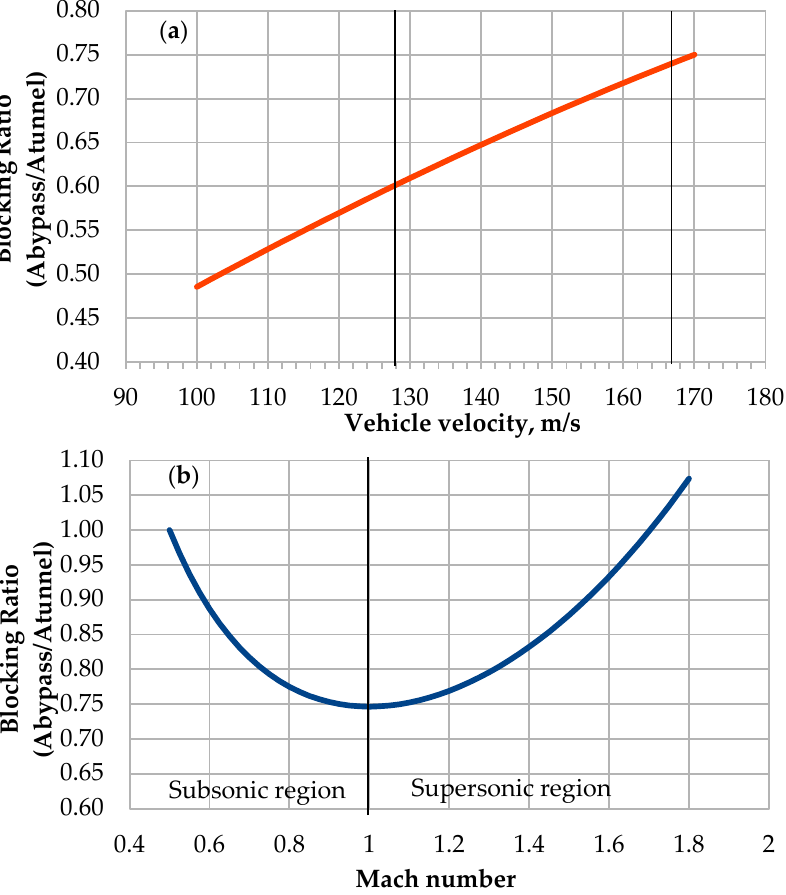
Figure 3. ( a ) Isentropic characteristic of blocking ratio in function of the vehicle velocity, with the assumption Ma = 1 in bypass between the vehicle and the tunnel; ( b ) isentropic characteristic of blocking ratio in function of Mach number for 166 m/s velocity of the vehicle.